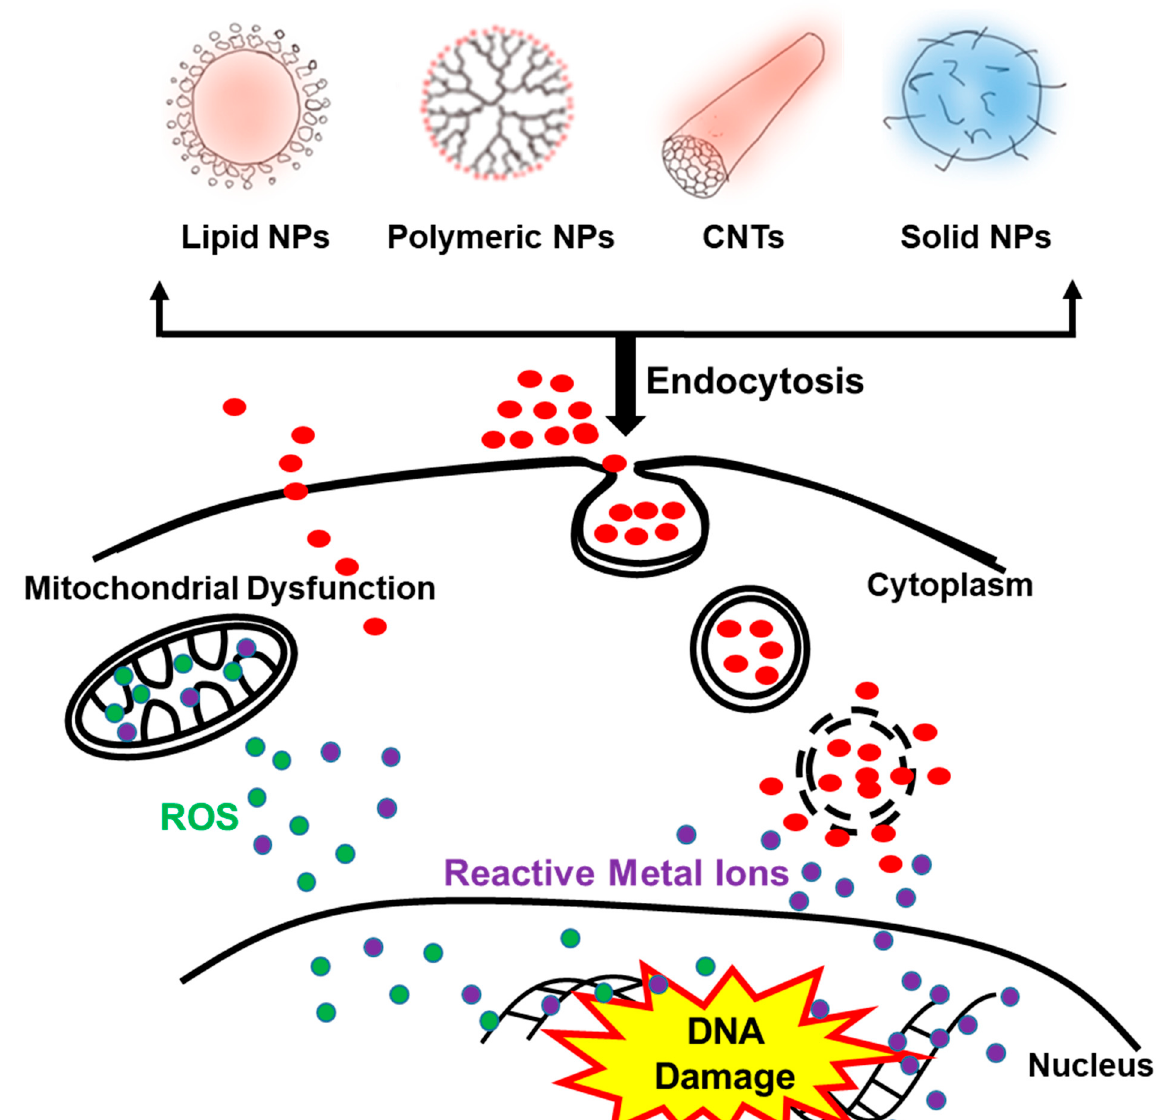
Figure 3. Cell–nanoparticle interactions and mechanism of NP toxicity. Following cellular uptake of NPs, NPs go through lysosomal pathways and result into release of reactive oxygen species and/or reactive metal ions causing mitochondrial dysfunction and DNA damage.